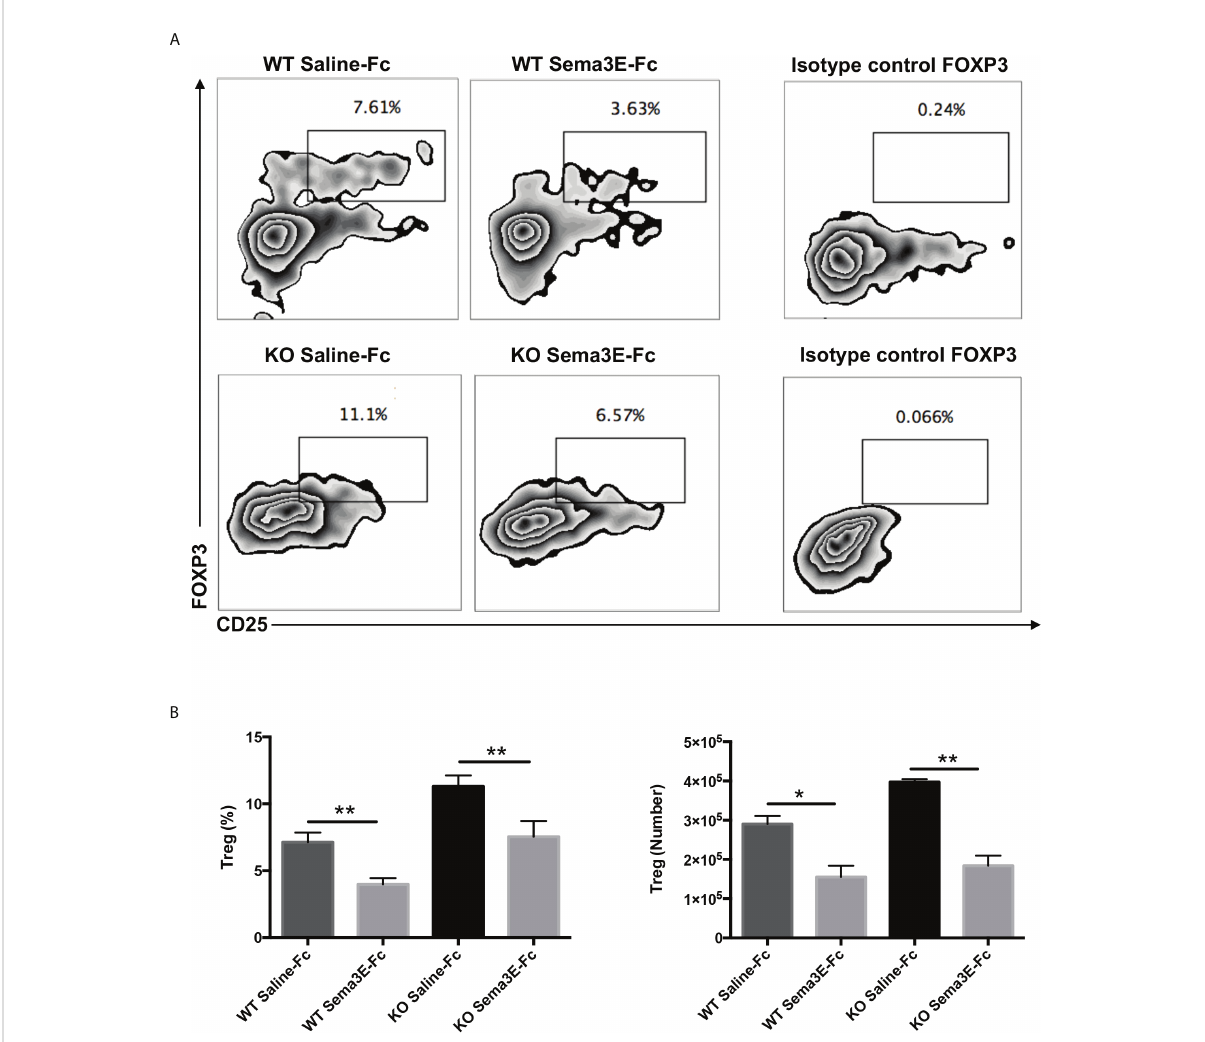
FIGURE 6 Lower Treg cells in the lungs of Sema3E-Fc treated mice following Cm infection. Mice were intranasally inoculated with 1x10 3 IFUs of Cm . Lung cells were collected from Sema3E-Fc, or saline-Fc treated WT and Sema3E KO mice on day 7 post-infection and stained for expression of CD3, CD4, and CD25. FoxP3 intranuclear staining was done on T cells to analyze Treg cells as described in Materials and Methods. (A) Representative fl ow cytometric images of Treg cells in the lungs. (B) The percentages and number of Treg cells in the lung. Data are shown as mean ± SD (n = 3) and represent one of three independent experiments with similar results. * p < 0.05, ** p <